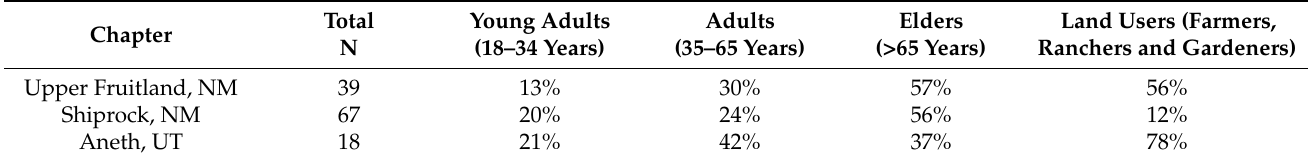
Table 1. Age and Land Use Status of Focus Group Participant by